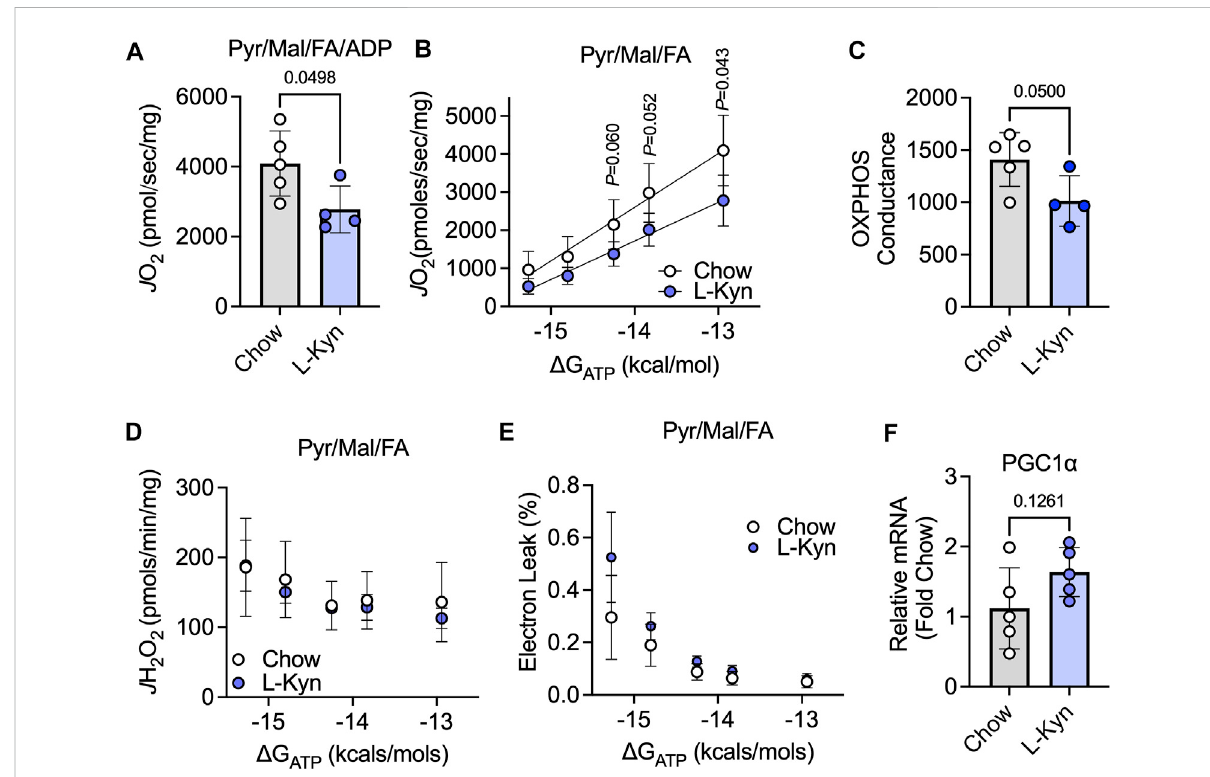
FIGURE 3 L-Kyn treatment impairs mitochondrial OXPHOS but does not affect H 2 O 2 production in skeletal muscle. (A) Maximal ADP-stimulated respiration supported by pyruvate, malate, and octanoylcarnitine (Pyr/Ma/FA). (B) Oxygen consumption ( J O 2 ) as a function of the free energy for ATP hydrolysis ( Δ G ATP )controlled byacreatinekinase clampsystem. (C) Quanti fi cation ofOXPHOS conductance(slope ofrelationship between J O Δ G Δ G 2 and ATP ). (D) Mitochondrial H 2 O 2 production measured at each level of ATP with Pyr/Mal/FA as substrates. (E) Estimated electron leak at each level of Δ G ATP with Pyr/Mal/FA as substrates. (F) Relative mRNA levels of PGC1 α in the gastrocnemius muscle. Error bars represent SD. N = 5/ group for all panels. Data in panels A,C,D,E were analyzed using a two-tailed Student ’ s t -test. Data in panel B were analyzed with a two-way